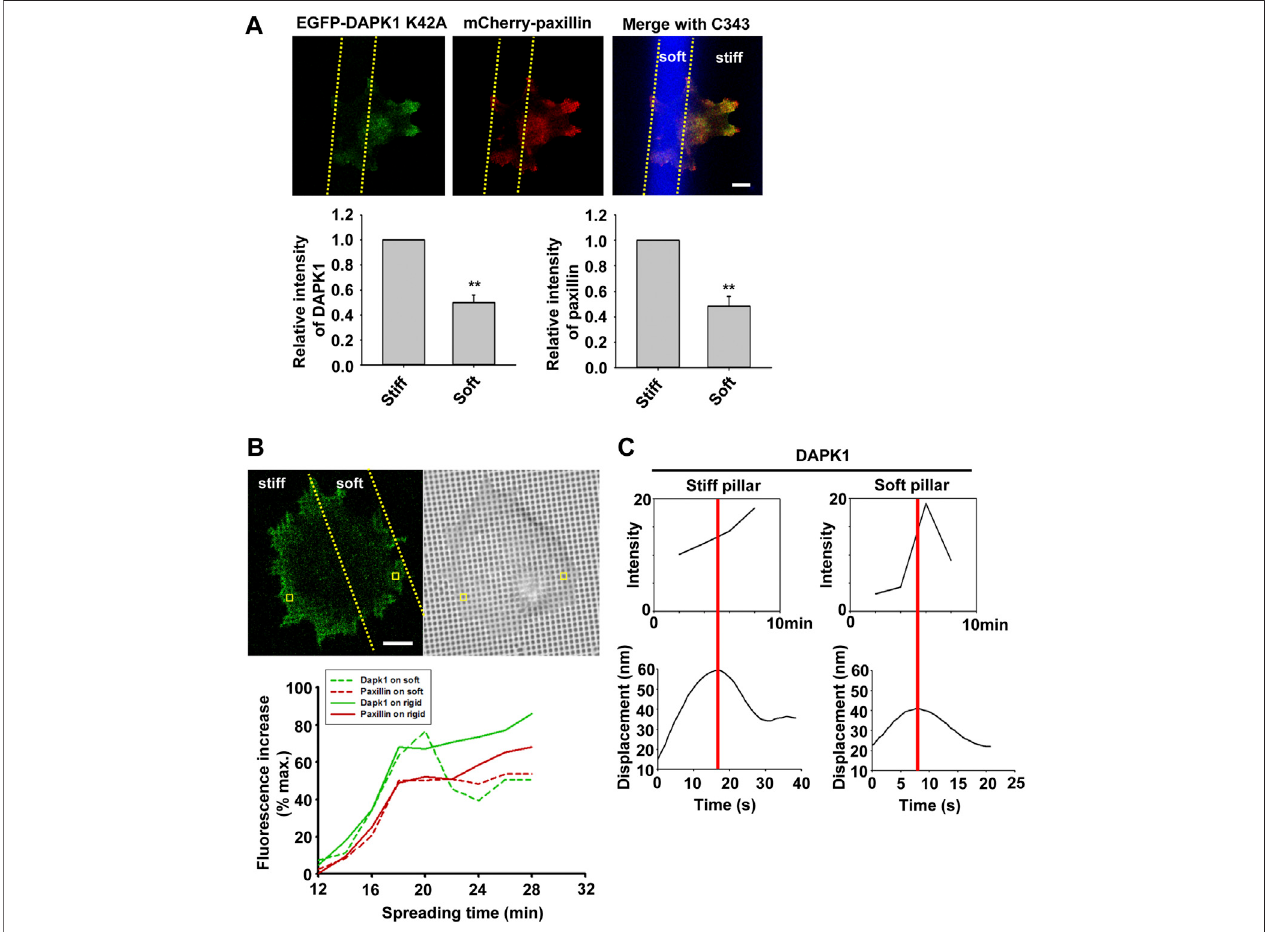
FIGURE 6| Dynamics ofDAPK1 during cell spreading on dual stiffness pillars. (A) MEFs were co-transfected withEGFP-DAPK1 K42A and mCherry-paxillin. Cells were spread (30 min) on dual stiffness pillars (9 kPa (Coumarin 343) and 170 kPa), Scale bar: 10 μ m. The leading edge protein relative intensity was normalized by dividingtheaverageintensityvaluewithin3 μ mofthecelledgeinstiffregionorsoftregionbytheaverageintensityvalueofthecelledgeinstiffregionofeach cell(stiff/stiff or soft/stiff). The relative intensity of DAPK1 or paxillin is presented in the lower panels. ** p < 0.01. N = at least 5 different cells in each group. Graphs represent mean ± SEM. (B) Upper panel: confocal image showing a cell transfected with EGFP-DAPK1 K42A and mCherry-paxillin on dual stiffness pillars. Scale bar: 10 μ m. Lower panel: one adhesion site of the cell corresponding to a single pillar within 2 μ m of outward curving cell edges in a stiff or soft region was tracked during cell spreading. The tracked pillar is marked by a yellow box. The relative fl uorescence of both molecules was plotted. (C) The time course of recruitment of DAPK1 was measuredduring pillar contraction and relaxation. Displacementsversus time ofcontractile pillars areshown inthelower panel. The peak ofthepillar contractionforce is marked by a red